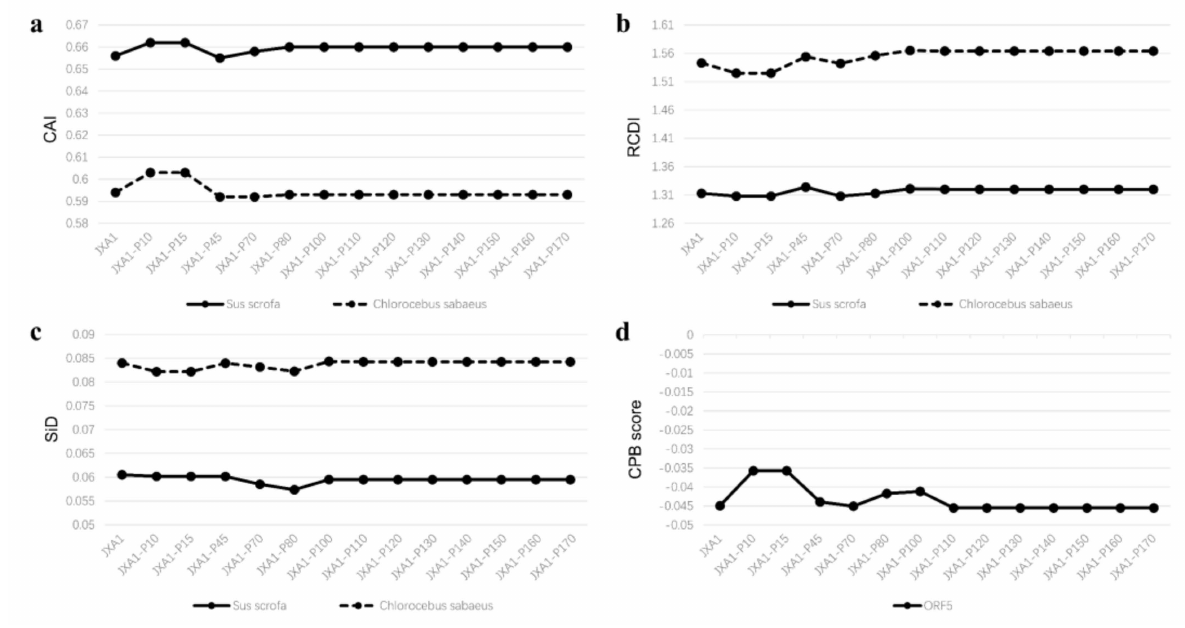
Figure 5. CAI ( a ), RCDI ( b ), SiD ( c ), and CPB scores ( d ) of ORF5 genes from different passages of JXA1 during